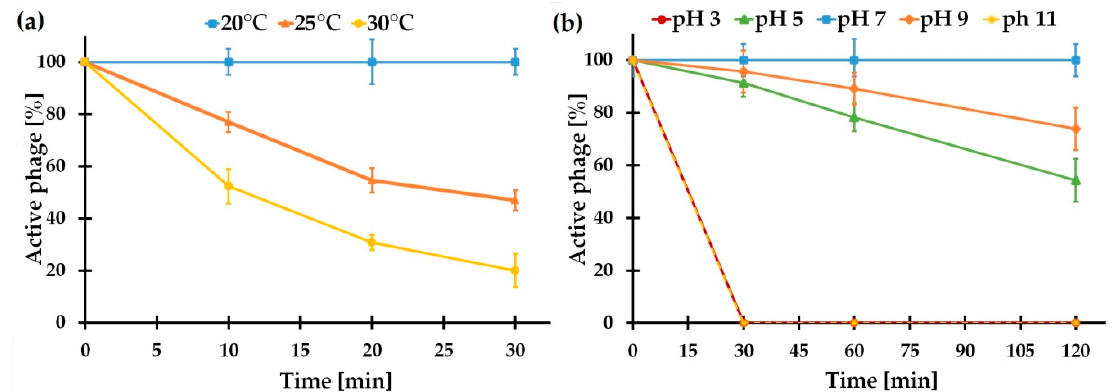
Figure 7. Phage BZS1 stability under various conditions. Effect of pH on the phage activity (a) . Effect of temperature on the phage activity (b) .